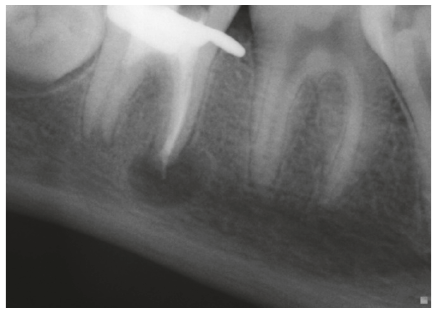
Figure 7: Radiograph 7 days after endodontic